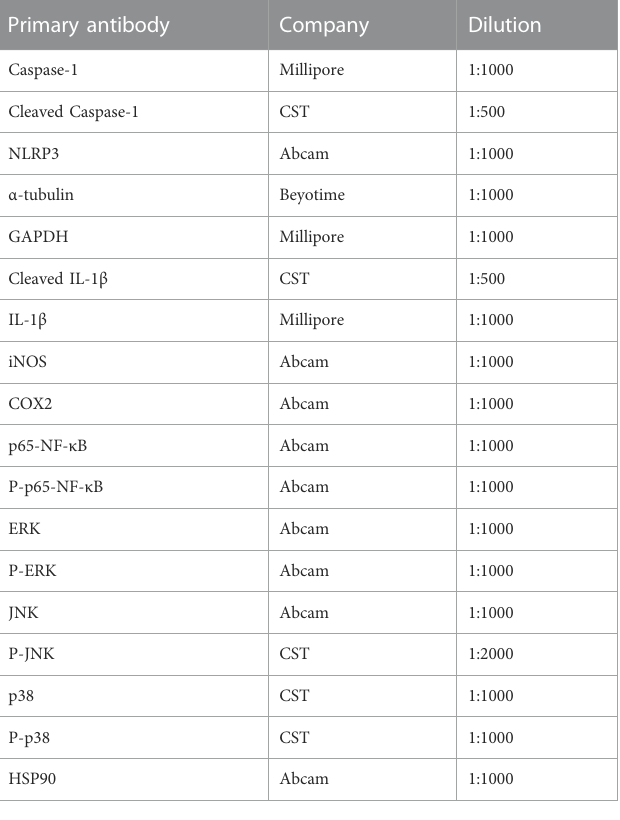
TABLE 2 Primary antibody